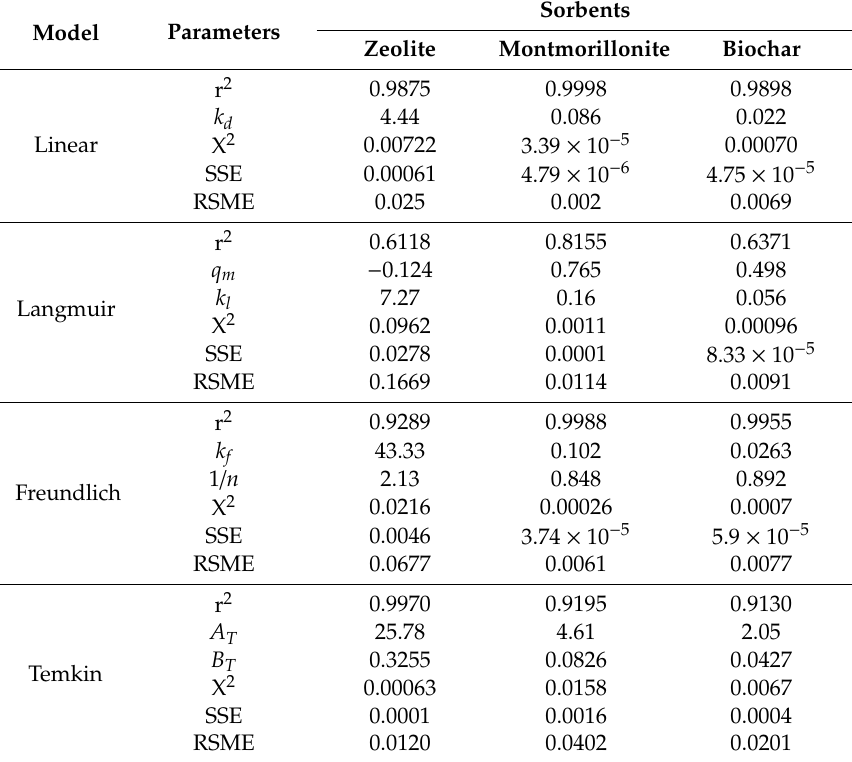
Table 2. The Linear, Langmuir, Freundlich, and Temkin isotherm parameters for 226 Ra adsorption. Sorbents Model Parameters Zeolite Montmorillonite